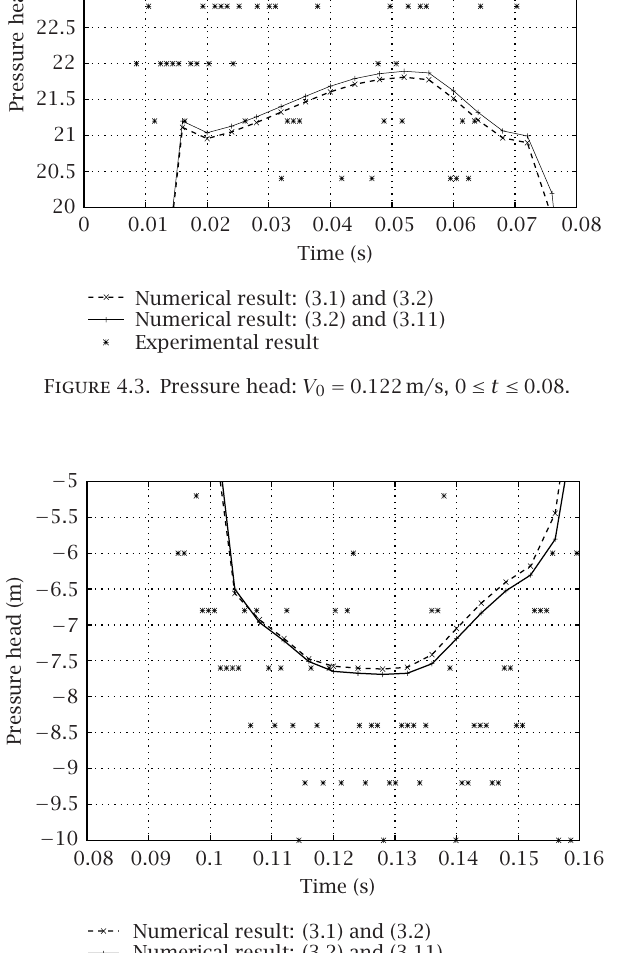
Figure 4.4 . Pressure head: V